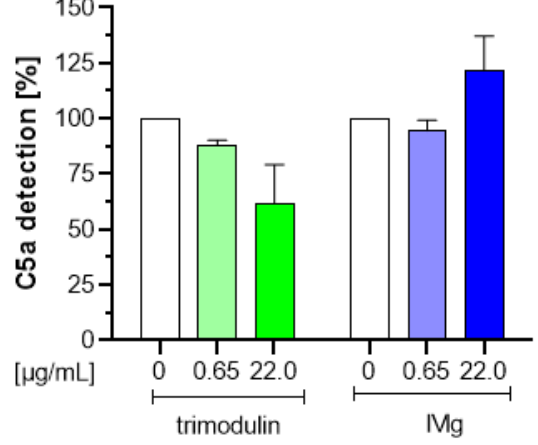
Figure 4. Trimodulin reduces C5a detection in a concentration-dependent manner. Anaphylatoxin binding assay showing different dilutions of trimodulin (green) and IVIg (blue) compared to the formulation buffer control (0, white bars). C5a was generated with zymosan via the AP and its binding to Igs was analyzed. Free C5a was detected by using a commercial C5a ELISA Kit. The amount of unbound C5a was set to 100% in the FB control. Data represent mean + SD from three independent experiments performed in duplicates. AP: alternative complement pathway; FB: formulation